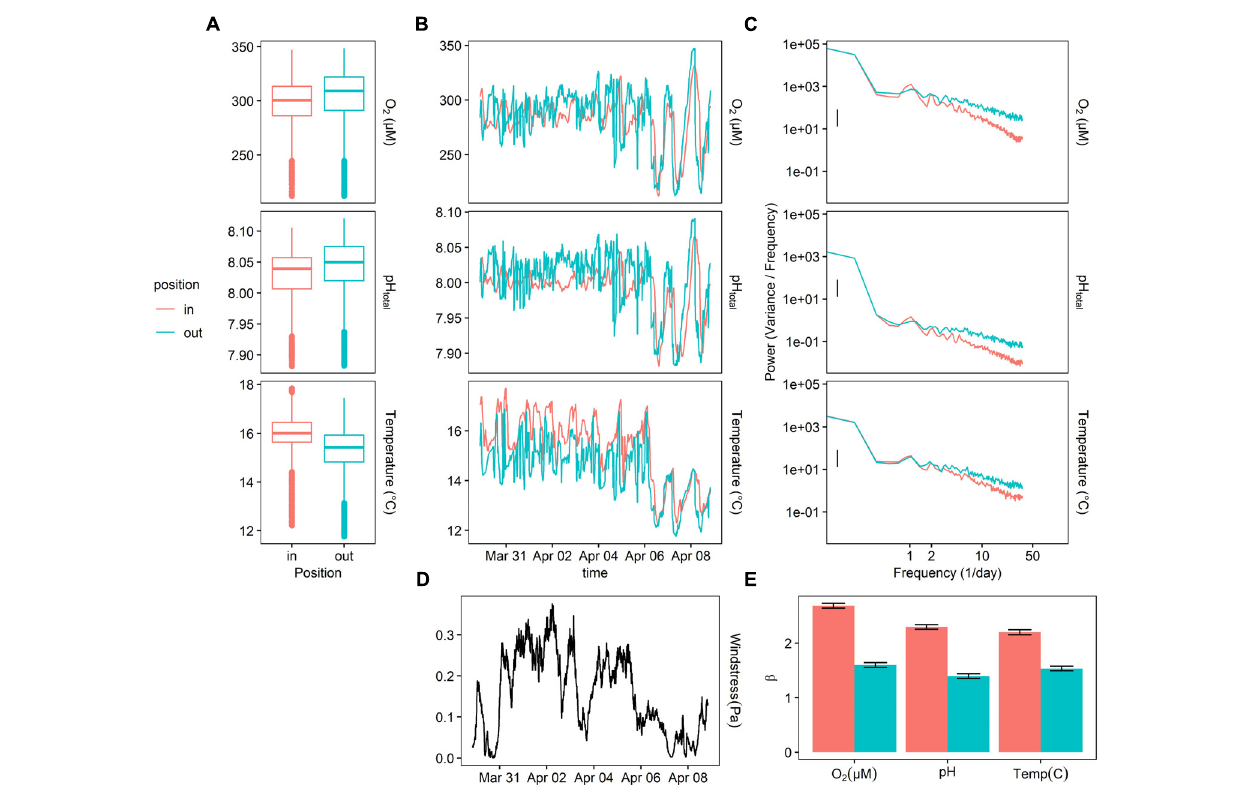
FIGURE 3 | Deployment 2 (March 10 – April 08, 2015) at MKO. (A) Boxplot of measured values for each sensor. (B) A 10-day representative sample of oxygen, temperature, and calculated pH data taken 1 m off the bottom, inside and outside of the kelp forest. (C) PSD of the entire deployment, for temperature and oxygen, (D) measurement of wind stress at the site, taken from NOAA NBDC #46054. (E) β indexes calculated for the entirety of the deployment, after subtracting the diurnal